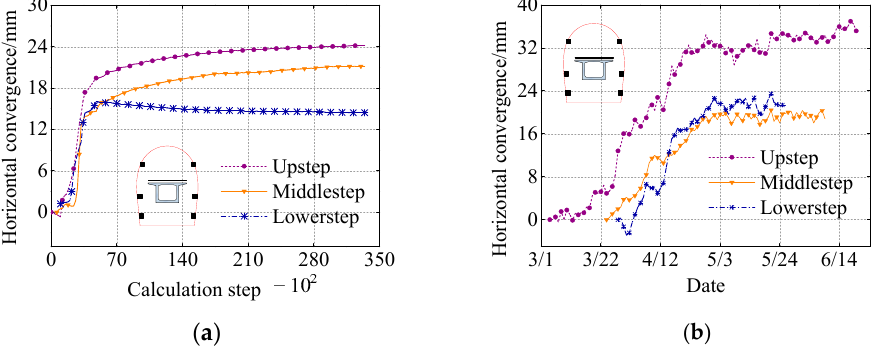
Figure 5. Horizontal convergence ( a ) simulated and ( b ) field monitor results of I-type tunnel.